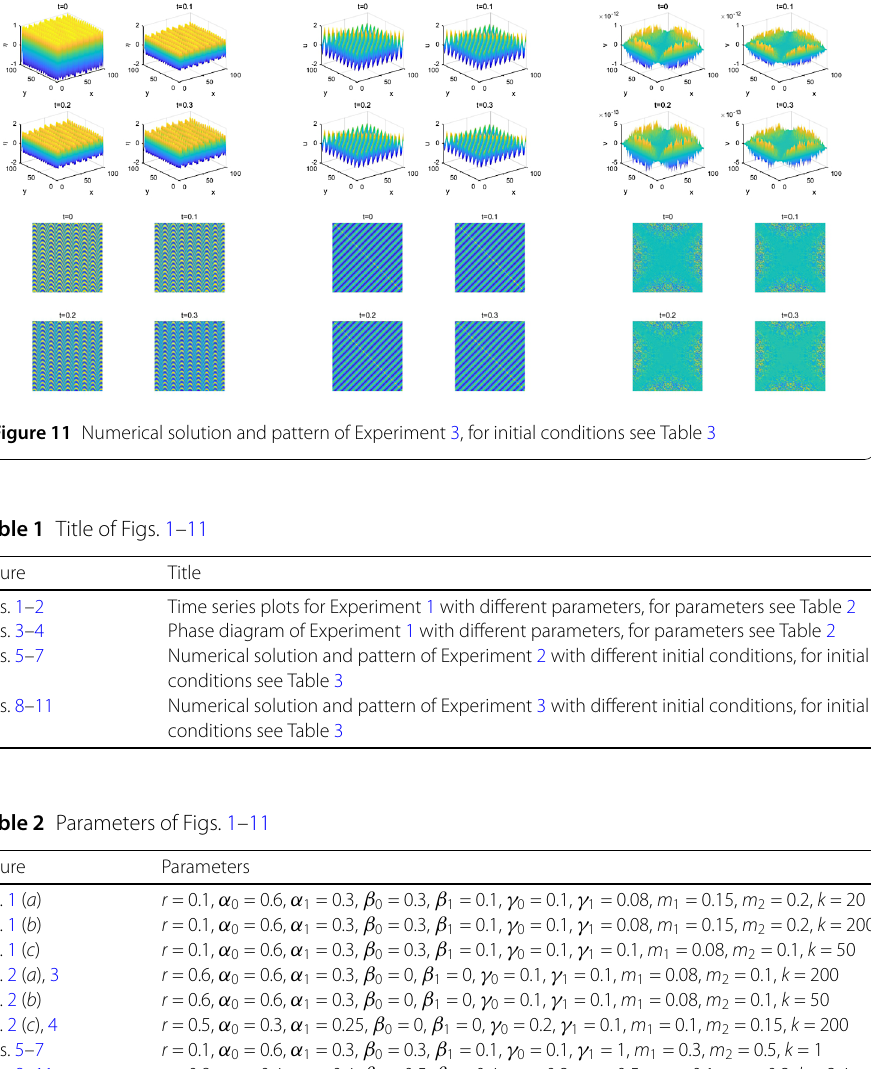
Table 3 Numerical solution and pattern of Experiments 2–3 with different initial condition of Figs. 5–11